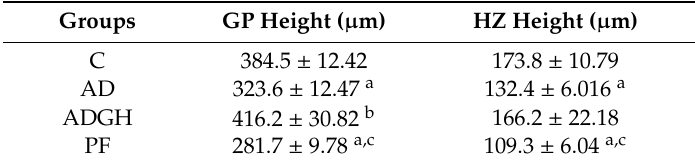
Table 3. Histological characteristics of the proximal tibial growth plate in the four groups of rats ( n ≥ 5 animals per group).